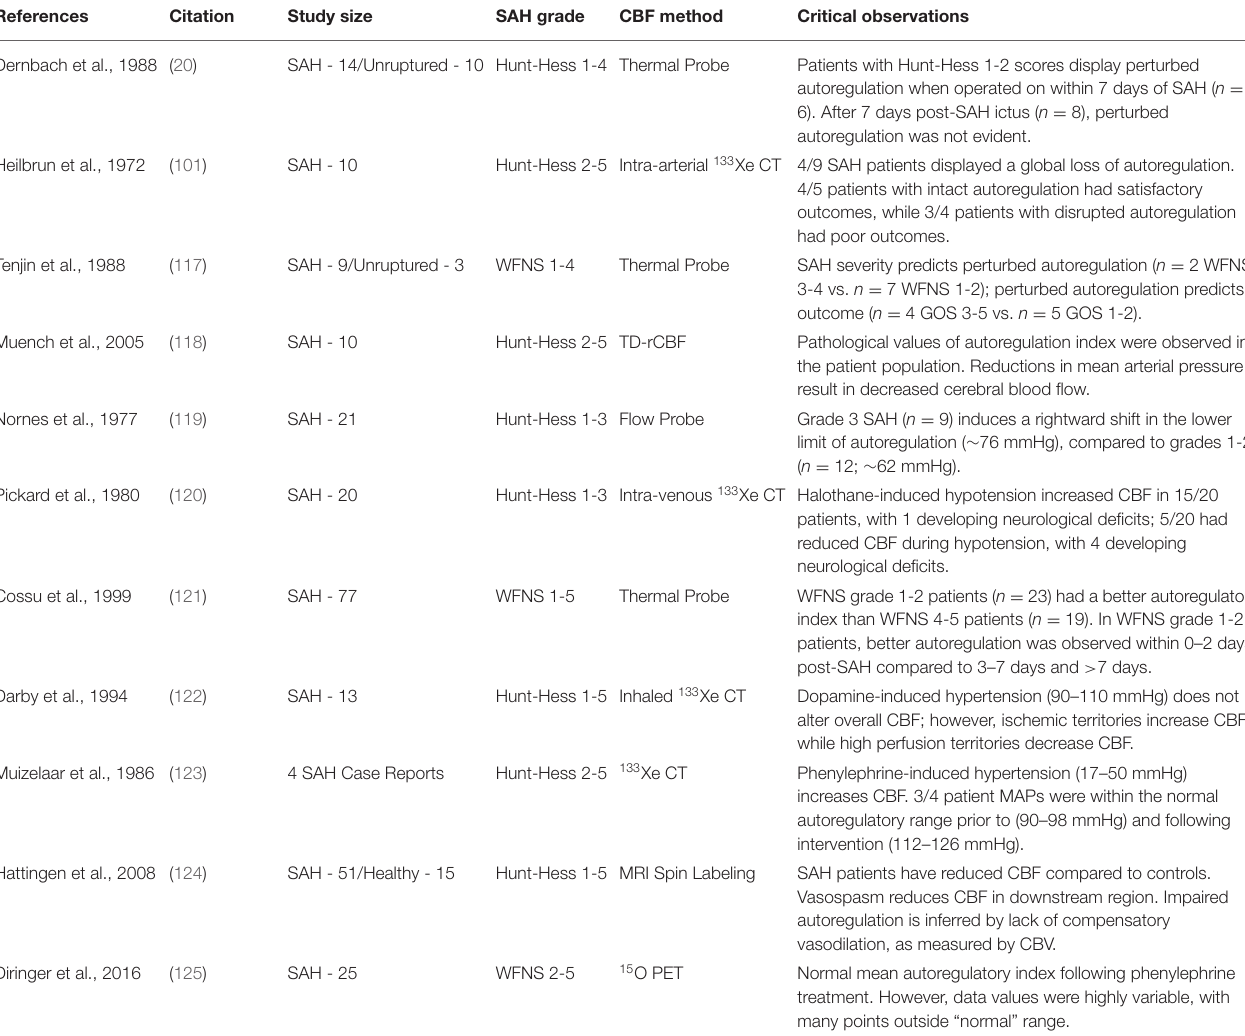
TABLE 2 | Clinical studies assessing cerebral blood flow autoregulation in subarachnoid hemorrhage